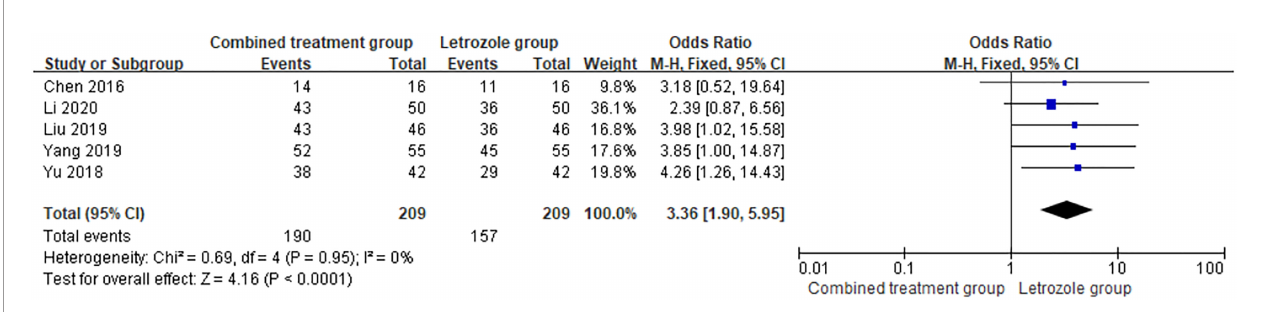
FIGURE 2 | Meta-analysis of the effect of Kuntai capsule combined with letrozole on the ovulation rate in polycystic ovary syndrome (PCOS).